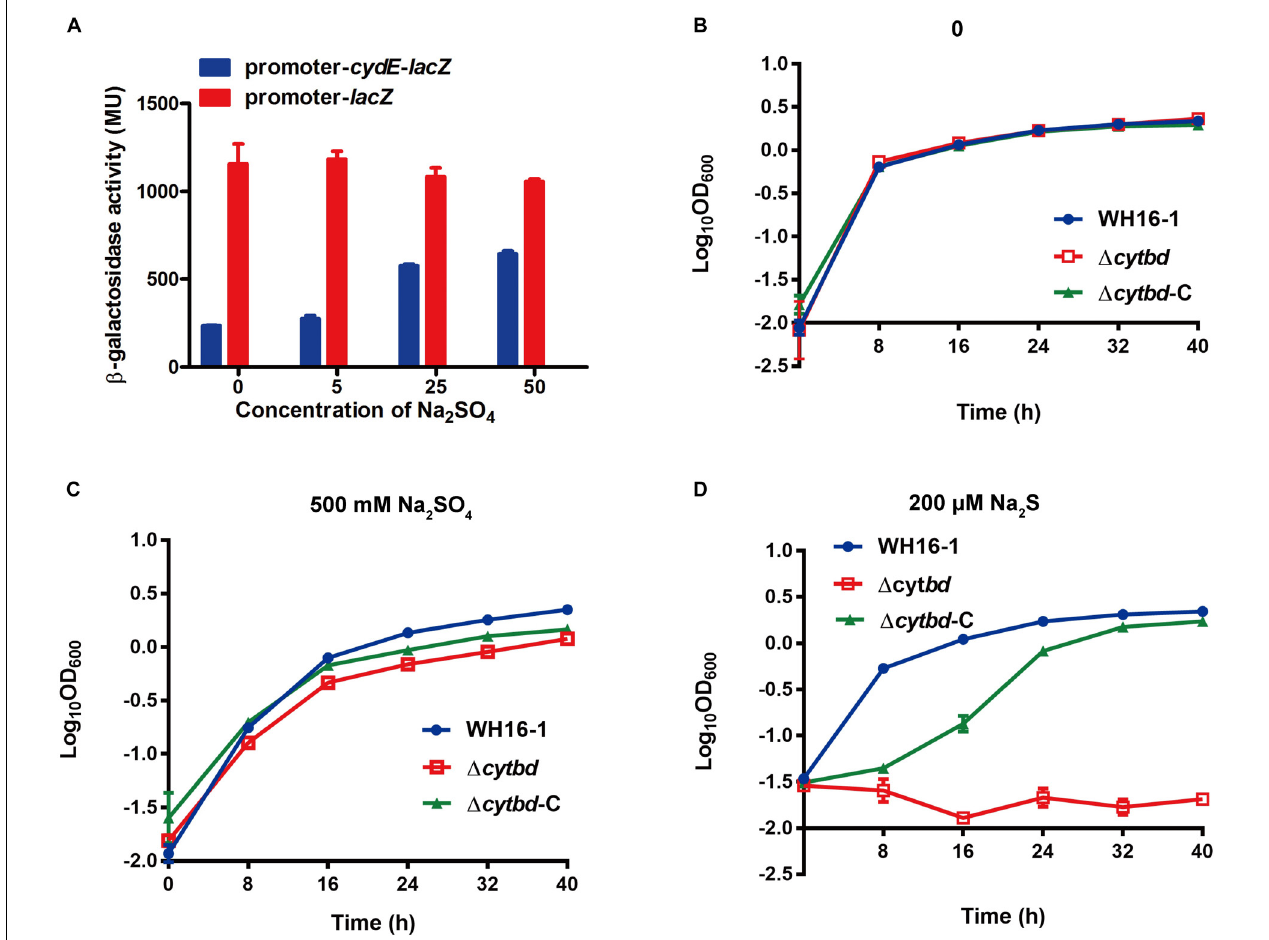
FIGURE 2 | Cytbd is induced by sulfate and contributes to sulfate and sulfide resistance. (A) Sulfate effects on Cytbd expression. β -Galactosidase activities were increased after adding sulfate or removing cydE behind the promoter. The growth of WH16-1 (wild type), (cid:77) cytbd (mutant strain), and (cid:77) cytbd -C (complemented strain) with 0 (B) , 500 mM Na 2 SO 4 (C) , or 200 µ M Na 2 S (D) in LB medium. The values represent averages and standard deviations of three